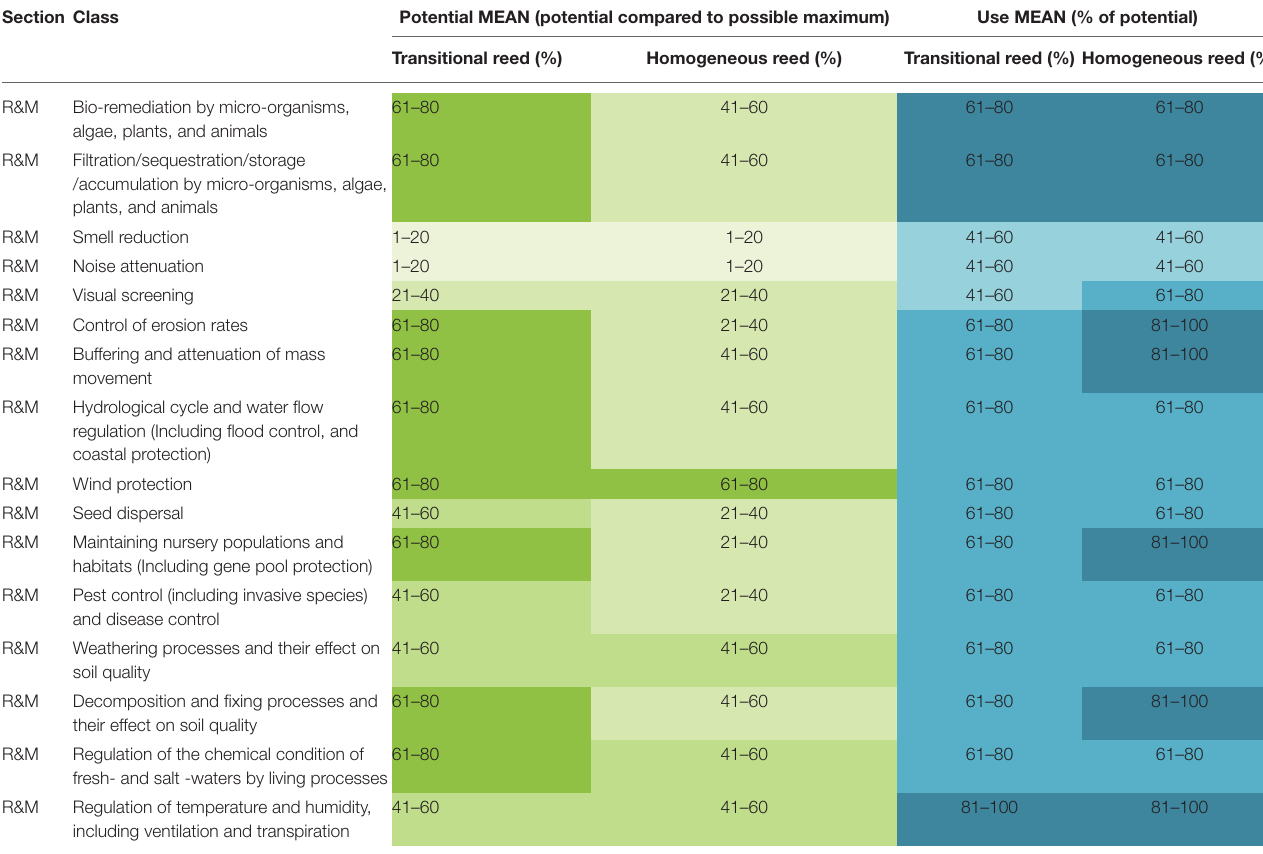
TABLE 1 | Results of the authors’ ecosystem service assessment for regulating services in transitional and homogeneous reed